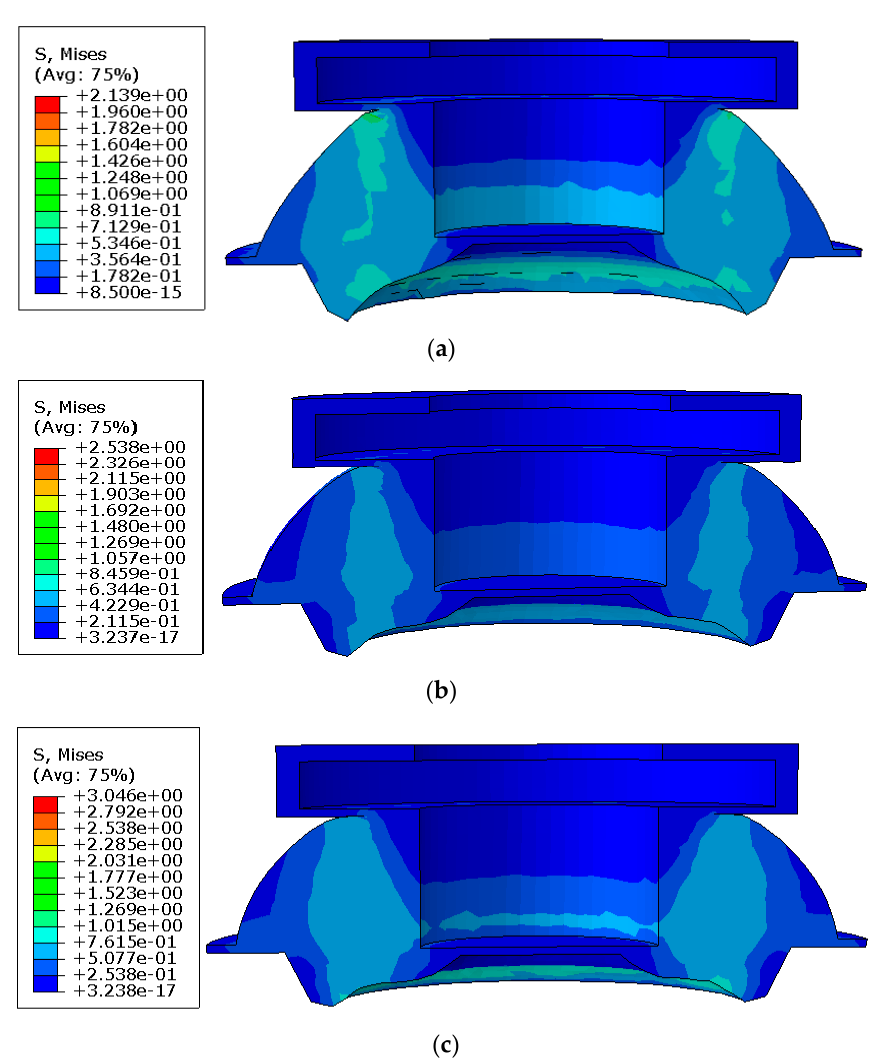
Figure 8. Finite element model of suspended main spring. ( a ) Mises stress cloud map of static stiffness without creep. ( b ) Mises stress map of 2.98 mm creep stiffness. ( c ) 3.83 mm